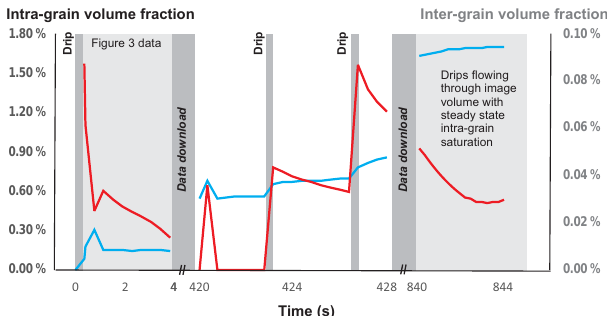
Figure 5. The change in fluid volume within the inter- (red) and intra-grain (blue) porosity over the experiment showing the arrival and subsequent equilibration of two drips. After the first drip the system equilibrates to very low inter-grain saturation. Data are from sample LH_9, scans 1 to